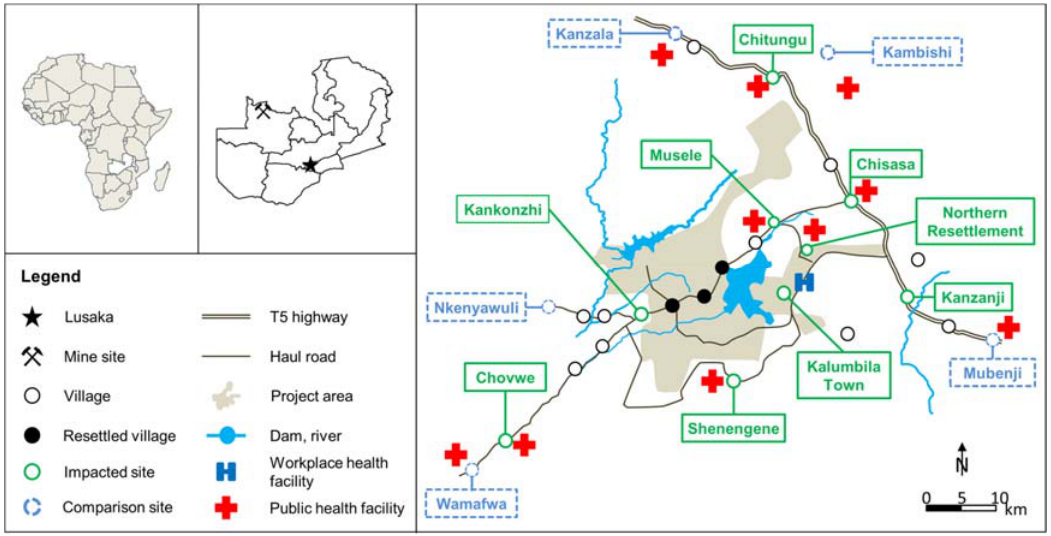
Figure 1. Study area and sentinel sites, Trident project, 2011 and 2015, Zambia.